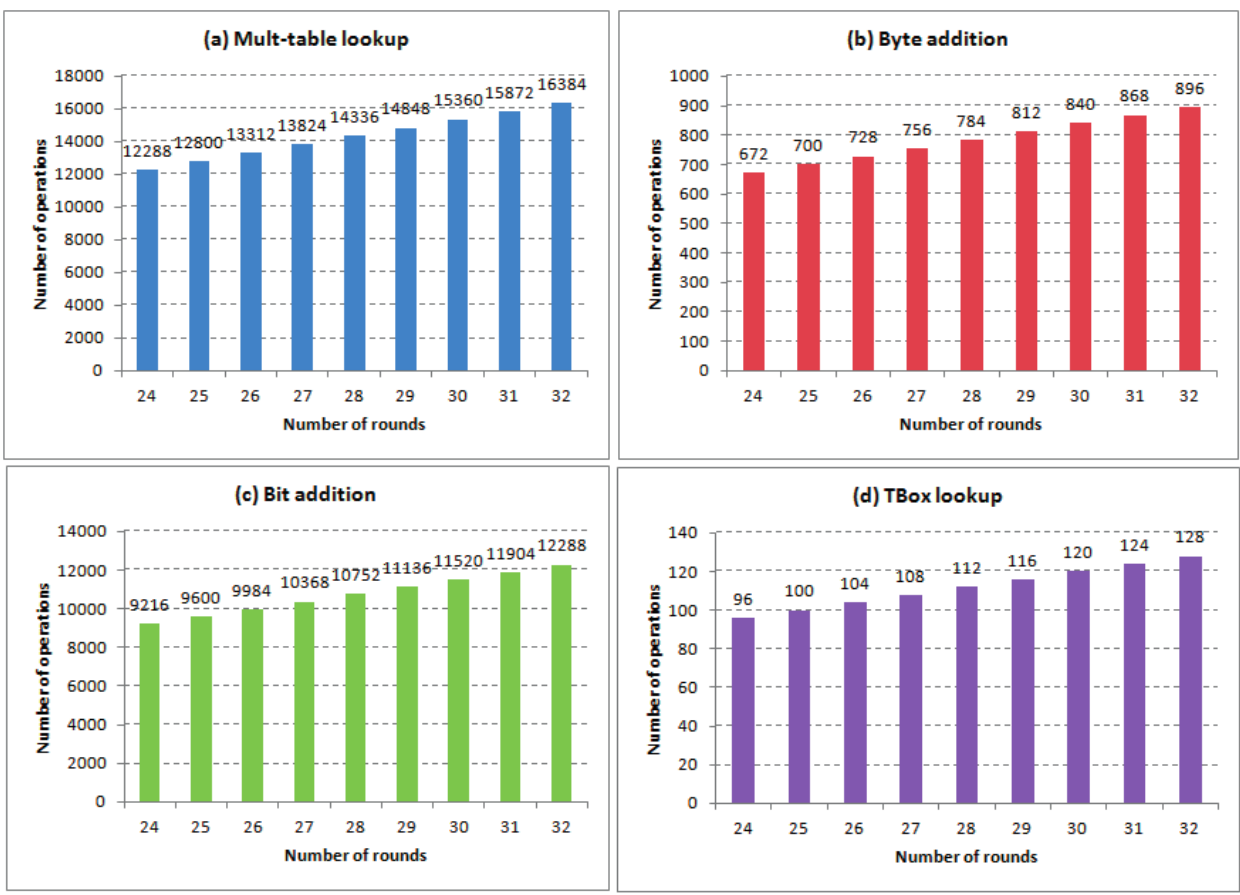
Figure 6. ( a ) The number of multi-table lookups; ( b ) The number of byte additions; ( c ) The number of bit additions; ( d ) The number of TBox lookups.